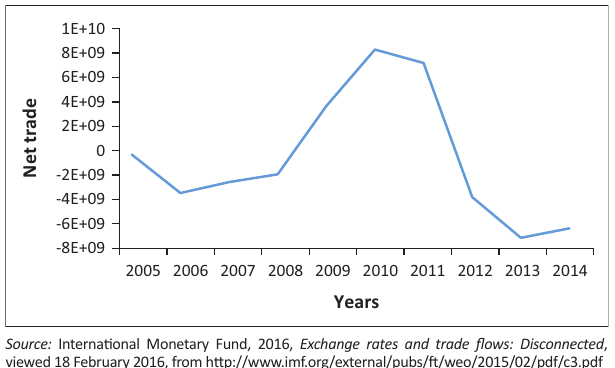
FIGURE 1: South African trade volumes in goods measured in current United States